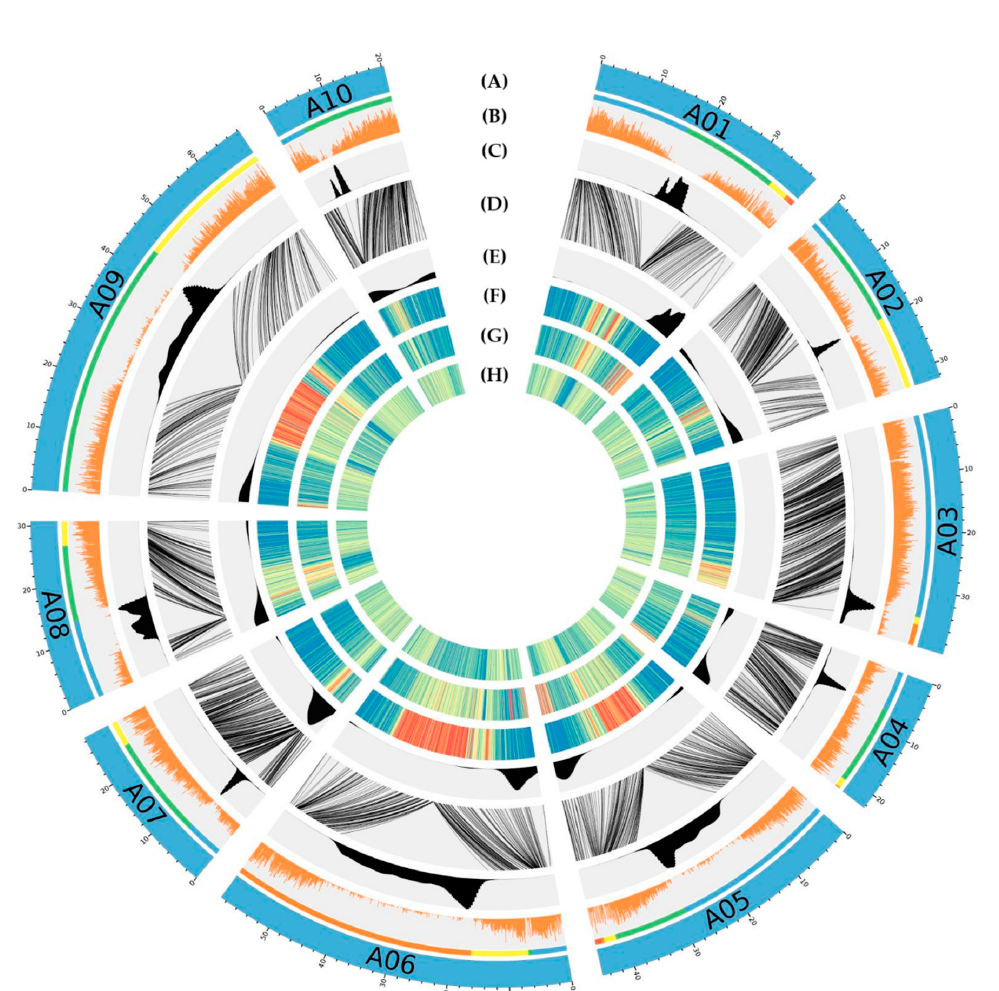
Figure 2. Circular representation of the 10 chromosomes obtained in this novel B. rapa cv Z1 assembly V2. ( A ) Scaffolds used to generate each pseudomolecule; ( B ) gene density; ( C ) putative position of (peri)centromeres; ( D ) relationships between the physical and genetic position of the SNP markers used to create the B. rapa genetic maps and order the scaffolds onto pseudomolecules; ( E ) density of subtelomeric satellite repeats; ( F ) density of Gypsy elements; ( G ) density of Copia elements; and ( H ) density of DNA retrotransposons.